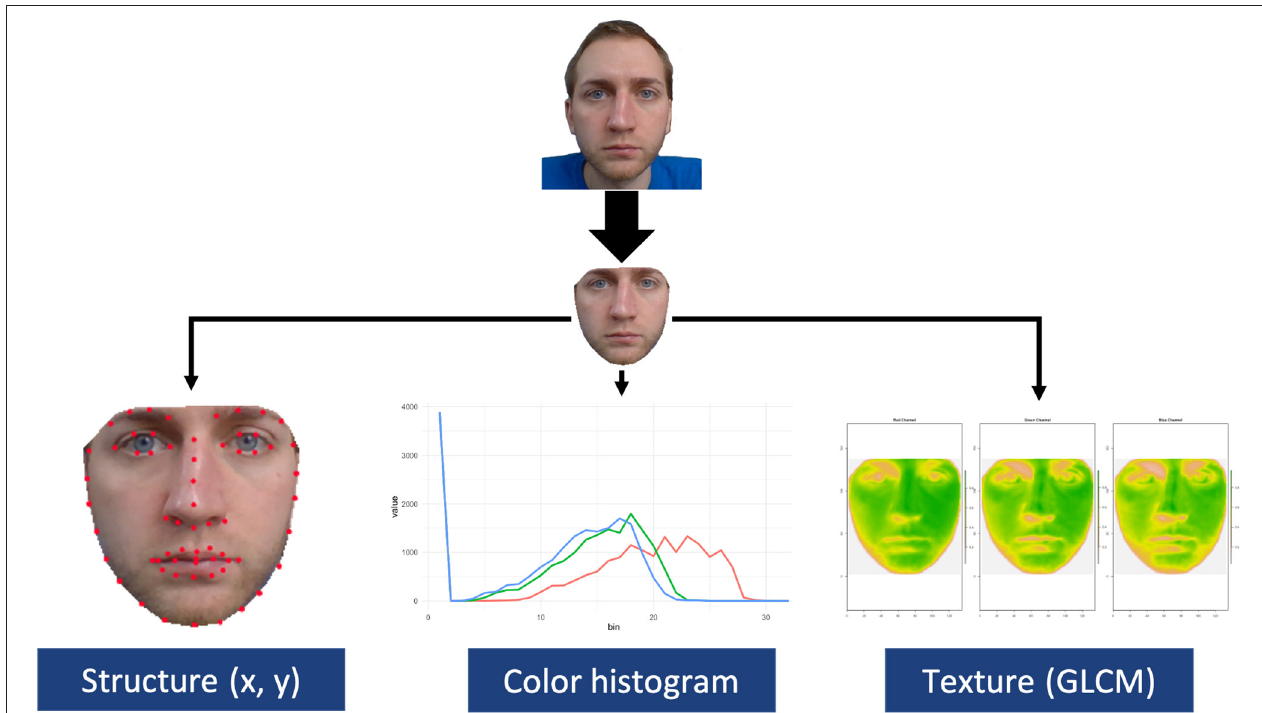
FIGURE 2 | Visual representation of feature extraction of structure, color, and texture from the internal portion of the face.